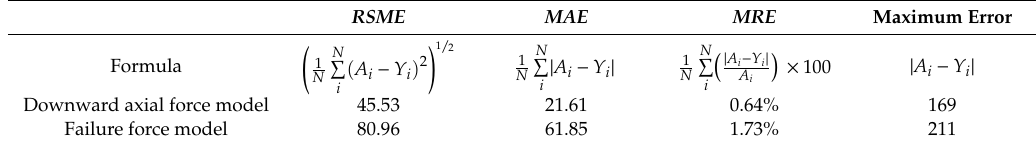
Table 6. The amount of di ff erent kind of errors for the developed ANN models.